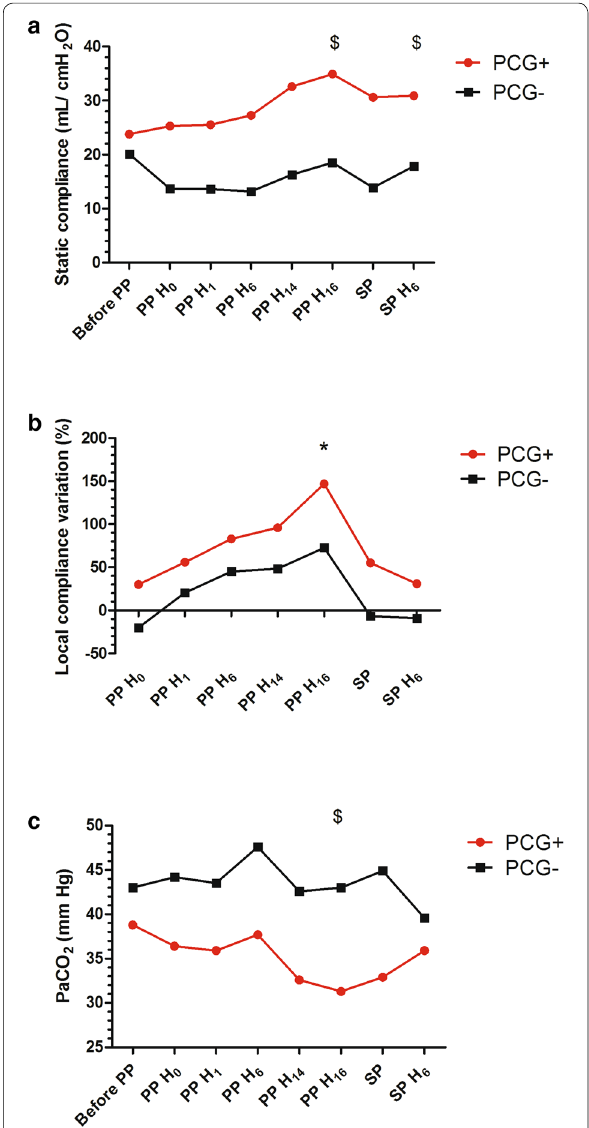
L/min, respectively. These benefits remained significant 6 h after return in SP ( P ˂ 0.0001) (Fig. 2). Interestingly, they exhibited a significant decrease in PaCO 2 from 39 (34–41) mmHg to 31 (29–37) mmHg after a PP session (p 0.03) without any variation of sweep gas flow (Fig. 2). = They significantly more frequently had viral pneumonia and higher body mass index than patients without static compliance gain. In addition, PCG required shorter + Fig. 2 a Trend of median static compliance variation; b median ECMO duration and ICU length of stay than PCG . local compliance variation compared to baseline (expressed in − percentage); and c impact of prone positioning on median PaCO 2 before, during, and after prone position for patients with an increase Tidal impedance variation and EELI of the static compliance by 3 mL/cmH 2 O (PCG ) (red) and patients After 16 h of PP, tidal impedance shifted significantly ≥ + with static compliance < 3 mL/cmH 2 OsPP after 16‑h of PP (PCG ) − to the dorsal ROI for all patients, regardless of the (black). PP: prone positioning; SP: supine positioning; * p < 0.005 vs. impact of PP on global compliance ( P < 0.05), with baseline for both PCG and PCG patients; $ p < 0.005 vs. baseline for + − PCG patients only VT dorsal /VT global ratio significantly higher after the + 16-h PP session versus baseline (Fig. 3). In addition, EELI located in the dorsal ROI increased by 240 ( 52 − to 666)%, while EELI located in ventral ROI decreased by 81 ( 156 to 107)% after 16 h of PP (Fig. 3). Fig- − ure 4 shows representative EIT findings before, dur- ing and after a PP session for PCG and PCG . The + − ventilation distribution before PP differed significantly between these two subgroups, with respective median